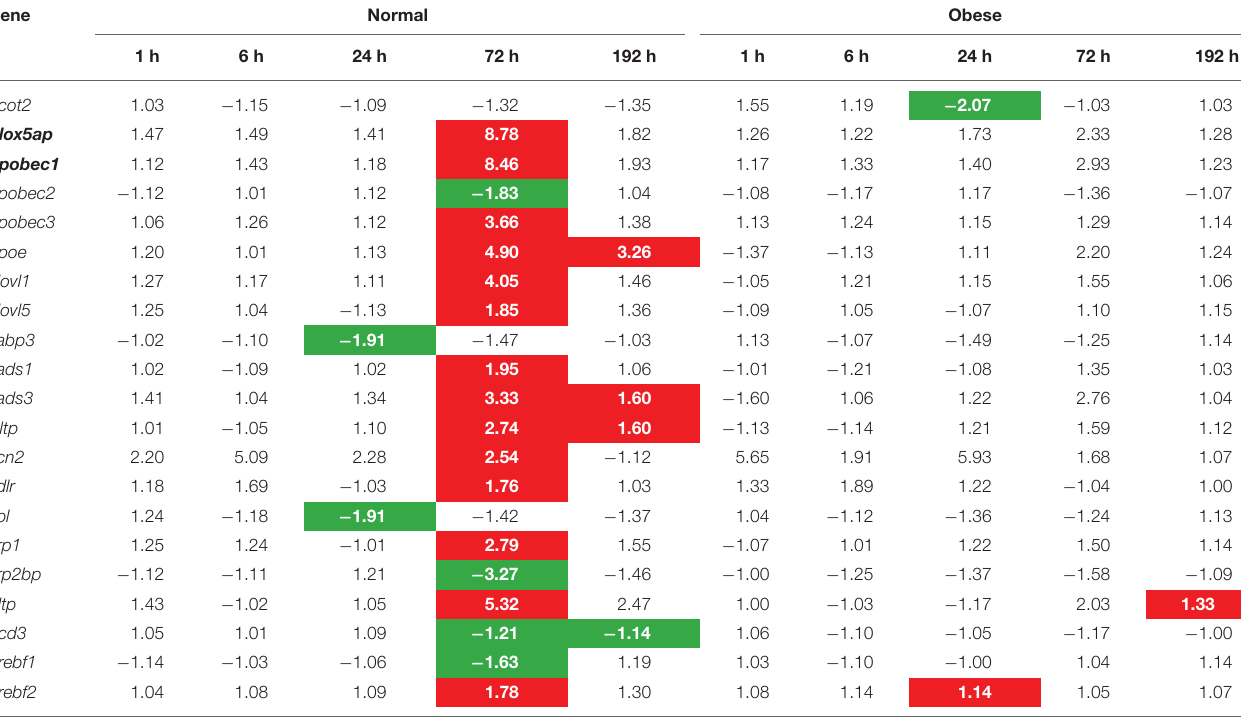
TABLE 6 | Expression levels of genes involved in fatty acid metabolism determined by microarray analysis. Gene Normal